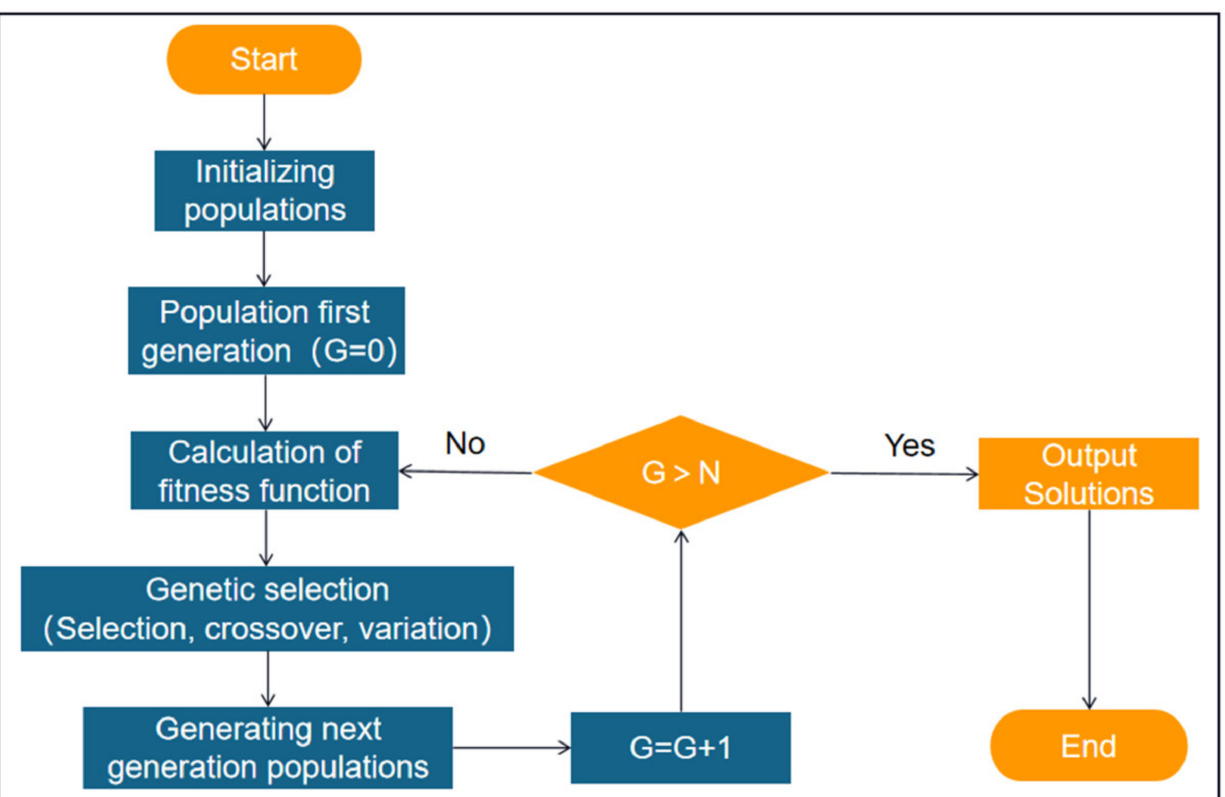
Figure 9. The single-objective optimization